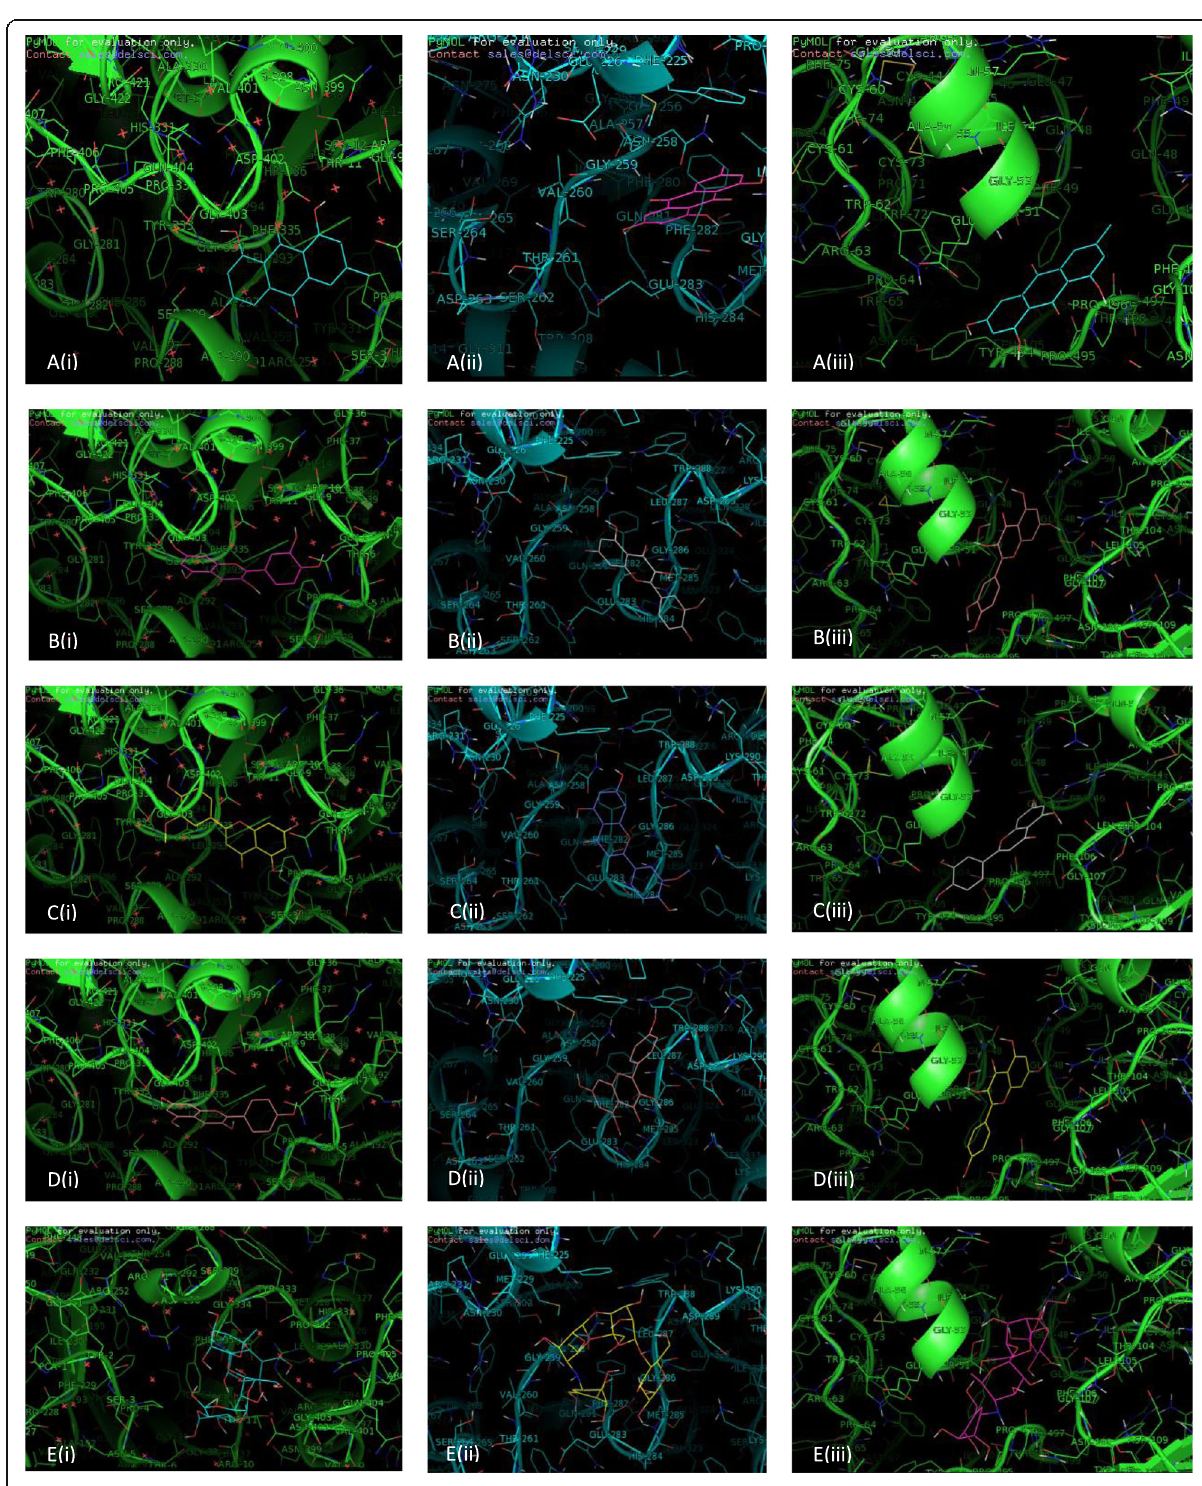
Fig. 1 Molecular docking of the compounds with the enzymes A(i) emodin and α -amylase (1HNY), A(ii) emodin and α -glucosidase (5ZCB), A(iii) emodin and sucrase-isomaltase (3LPO), B(i) quercetin and amylase, B(ii) quercetin and α -glucosidase (5ZCB), B(iii) quercetin and sucrase- isomaltase (3LPO), C(i) chrysoeriol and amylase (1HNY), C(ii) chrysoeriol and α -glucosidase (5ZCB), C(iii) chrysoeriol and sucrase-isomaltase (3LPO), D(i) kaempferol and amylase (1HNY), D(ii) kaempferol and α -glucosidase (5ZCB), D(iii) kaempferol and sucrase-isomaltase (3LPO), E(i) acarbose and amylase (1HNY), E(ii) acarbose and α -glucosidase (5ZCB), and E(iii) acarbose and sucrase-isomaltase